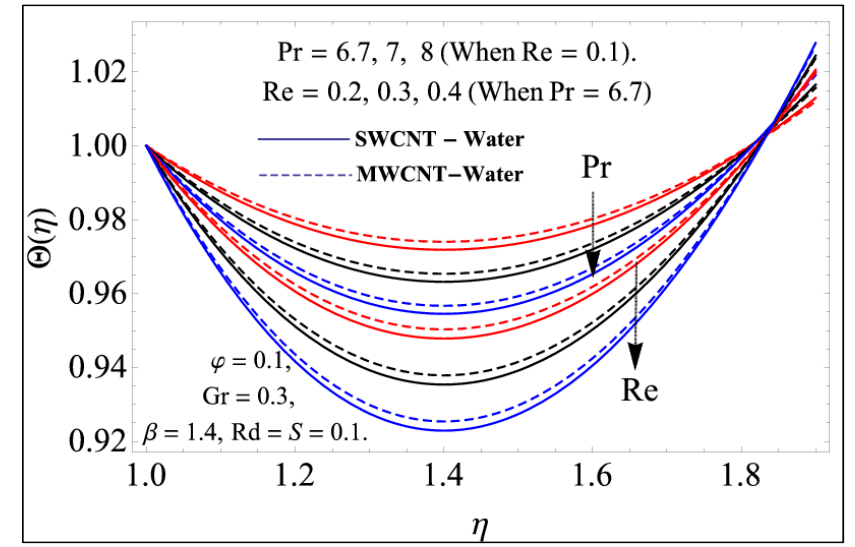
Figure 8. Impact of the Pr & Re on the temperature field.